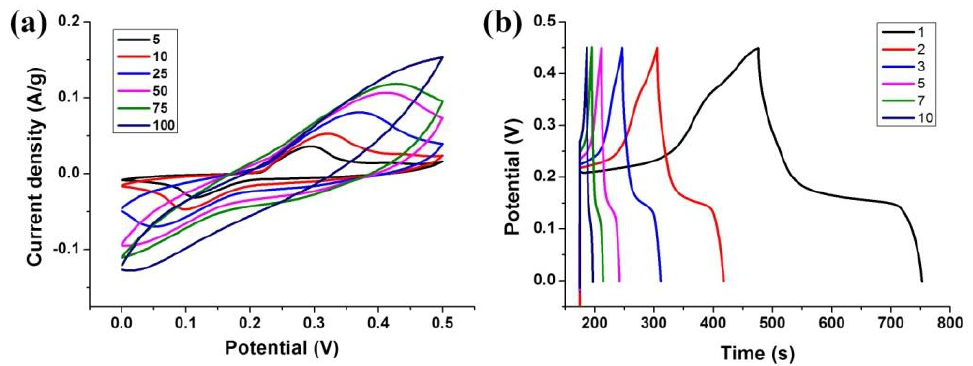
Figure 6. ( a ) Evolution of CVs of Ni-BTC-1 at various scan rates: 5, 10, 25, 50, 75, and 100 mV/s; and ( b ) charge-discharge diagrams of Ni-BTC-1 at different current densities: 1, 2, 3, 5, 7, and 10 A/g.